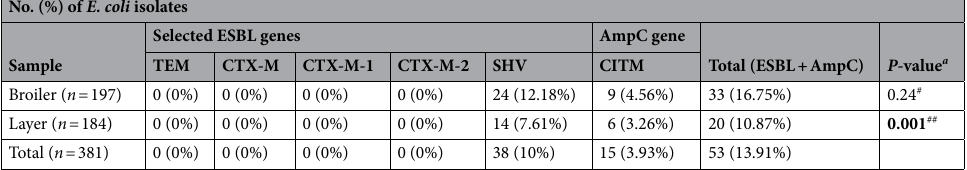
Table 8. Overall prevalence of beta-lactam (ESBL and AmpC) antibiotic resistant genes among the investigated E. coli ( n = 381) isolates in relation to type of hens (broiler or layer) in Sylhet division of Bangladesh. a P values calculated using a two-way analysis of variance (ANOVA) without replication. P values < 0.05 are highlighted in bold. # Variance between broiler and layer chickens. ## Variance among the beta-lactam antibiotic resistant genes.